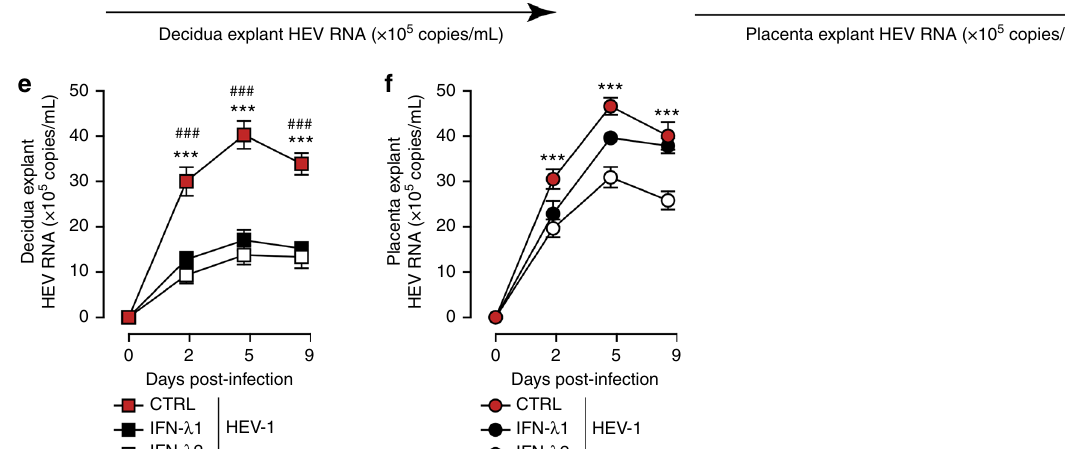
HEV-1 and HEV-3 at the maternal-fetal interface, we assessed the infectivity of HEV-1 and HEV-3 progeny virions. Equivalent copy number of viral RNA recovered from HEV-1 and HEV-3 infected decidual and placental explant supernatants were used to infect primary stromal cells or HepG2/C3A cell line. Data depicted in Fig. 8 demonstrate that supernatants recovered from infected tissues contain infectious progeny virions that can replicate in